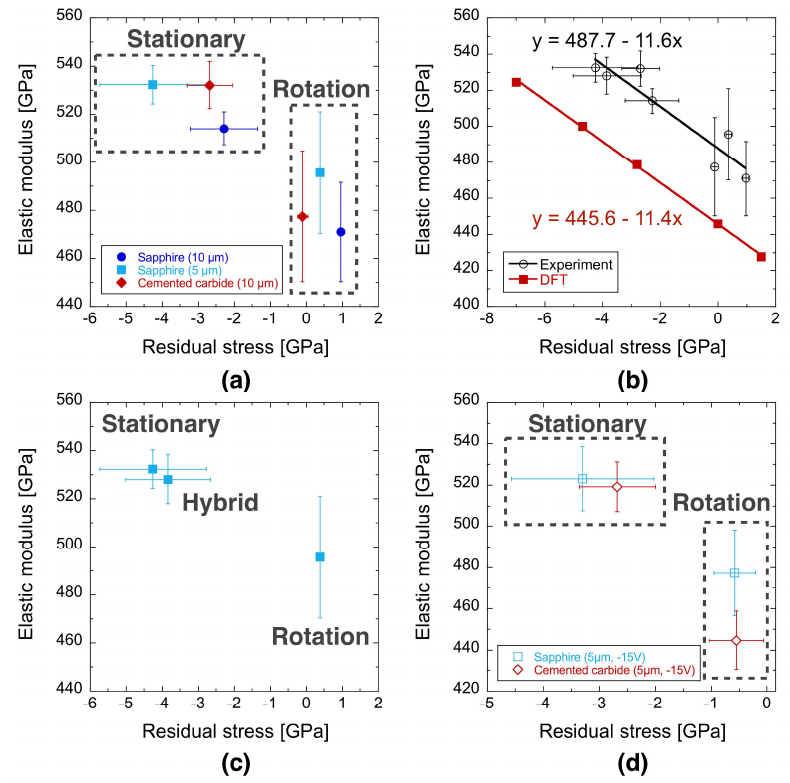
Figure 3. Stress-dependent elasticity of TiAlN, comparing ( a ) the rotation and stationary deposition geometry for different substrate material and film thicknesses, ( b ) DFT predictions (configuration with minimum number of Ti-Al bonds at room temperature) and experimental data, ( c ) the rotation, stationary and hybrid deposition geometry for a thickness of 5 µm on sapphire, and ( d ) the rotation and stationary deposition geometry for different substrate materials at a substrate bias voltage of −15 V. All coatings displayed in ( a – c ) were grown at floating potential.